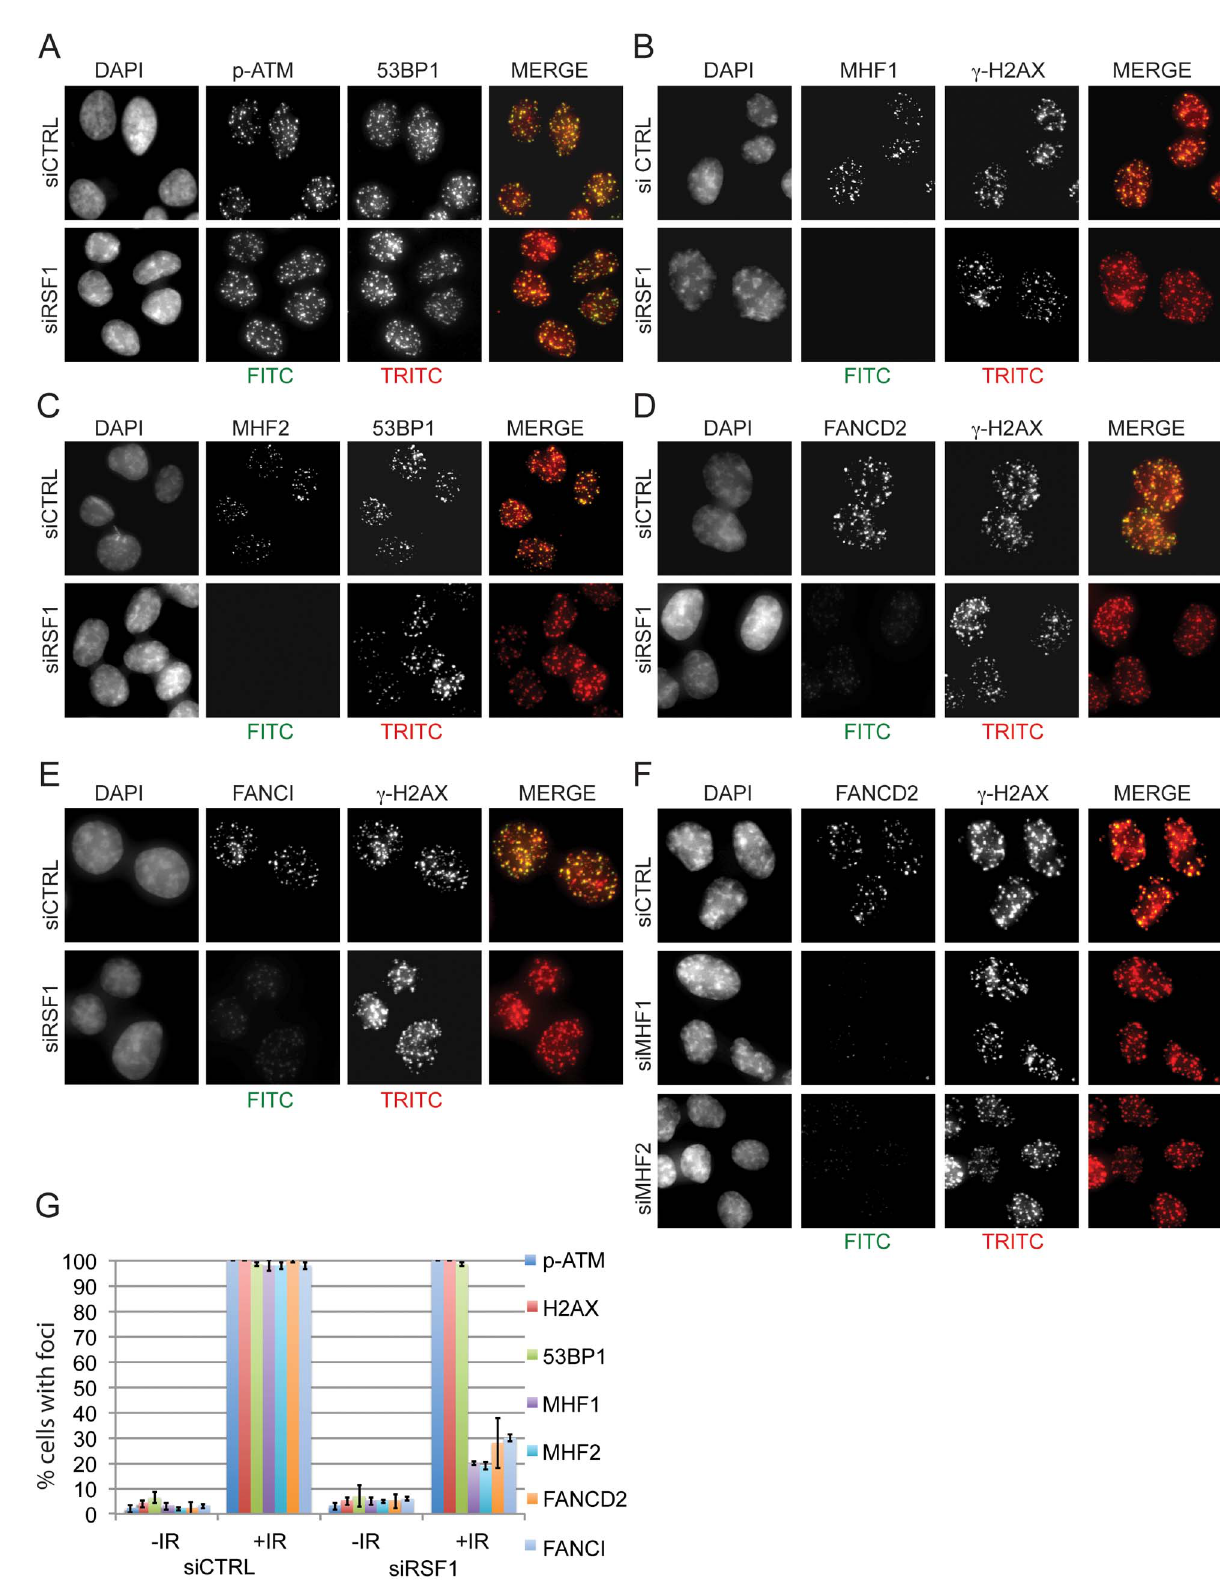
Figure 6. RSF1 is required for the recruitment of CENPS/MHF1, CENPX/MHF2, FANCD2, and FANCI to IRIF. (A–F) Immunofluorescence of the indicated proteins 60 min after IR (4 Gy) in the indicated siRNA-treated U2OS cells: (A) p-ATM and 53BP1, (B) MHF1 and c -H2AX, (C) MHF2 and 53BP1, (D) FANCD2 and c -H2AX, (E) FANCI and c -H2AX, and (F) FANCD2 and c -H2AX. (C) Quantification of pATM, c -H2AX, 53BP1, MHF1, MHF2, FANCI,